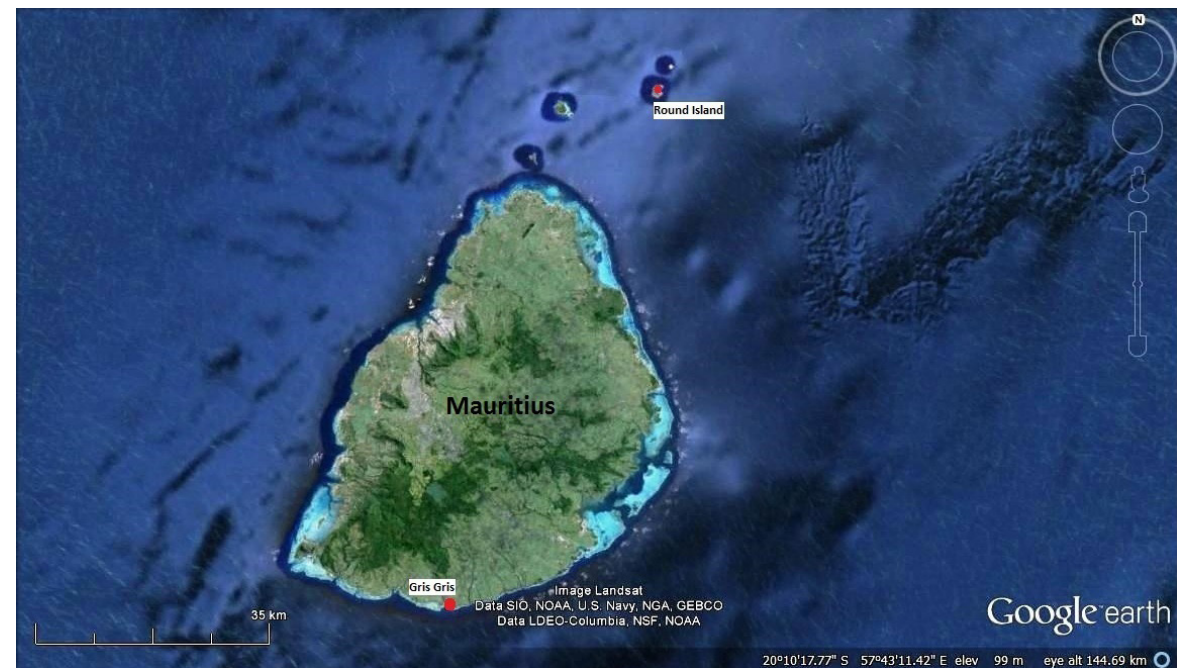
Image 2. Distribution (red dots) of Aerva congesta on Mauritius (including Round